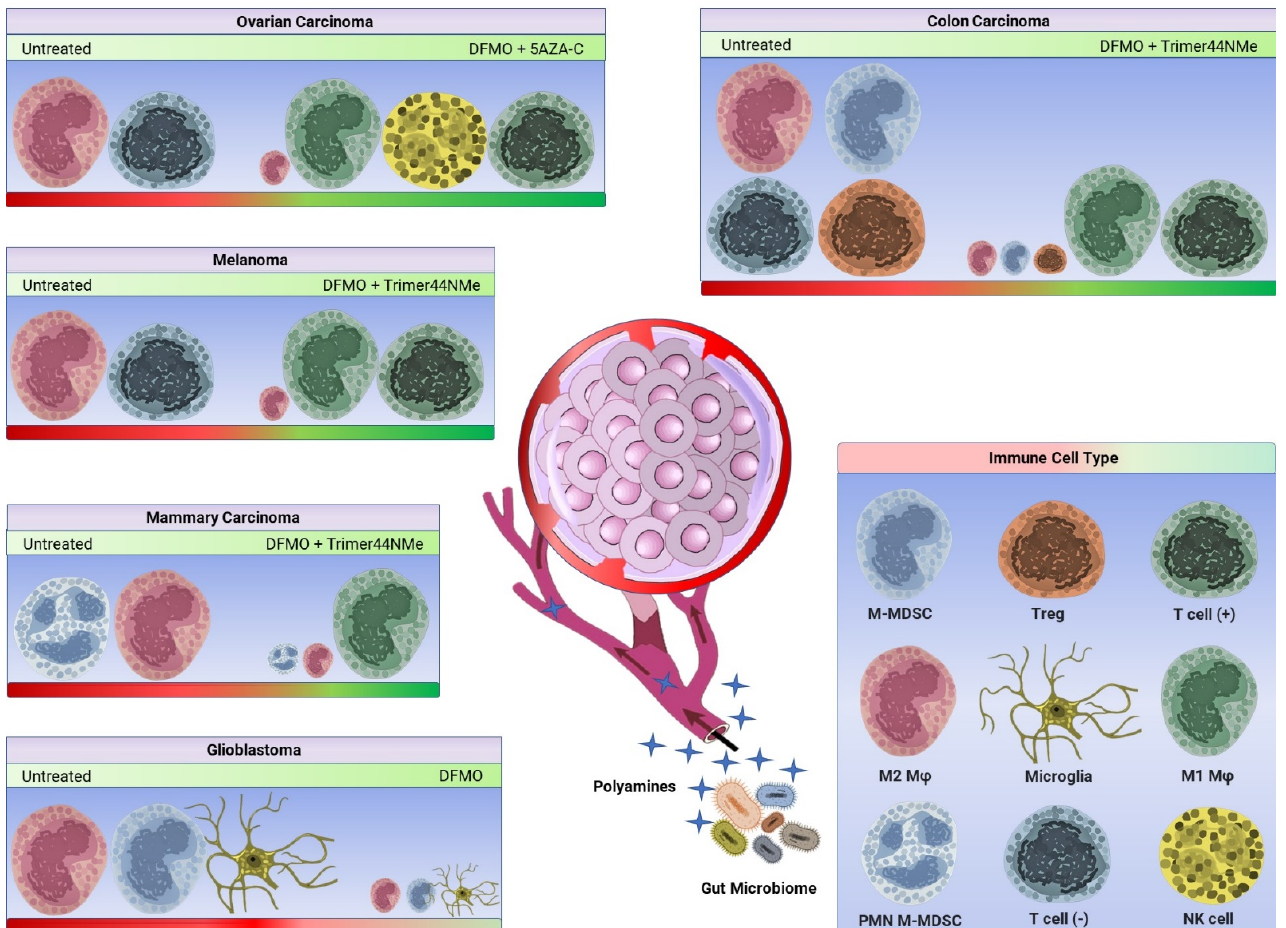
Figure 2. Polyamine blocking strategies decrease immunosuppression in multiple animal models of cancer. The tumor microenvironment (TME) presents anti-inflammatory cytokines and chemokines to support tumor growth; tumor- and gut microbiome-derived polyamines may further enhance immunosuppression [17,22]. Of the cancers examined, the respective panels are comprised of no-treatment (left) and treatment groups (right) and delineate significant alterations in the immune landscape. The red-green bar indicates the shift from an anti-inflammatory to pro-inflammatory phenotype, and the size of respective immune cells indicates the shift in observed frequencies as reported in the following articles. The immune cell types are labeled accordingly, and of note T cell ( − ) indicates a non-inflammatory and/or exhausted phenotype. DFMO and Trimer44NMe polyamine transport inhibitor (PTI) significantly reduced Ly6G+ polymorphonuclear myeloid-derived suppressor cells (PMN-MDSCs) and M2 macrophages (M2 M ϕ ) in the 4T1 orthotopic mammary carcinoma model [33]. DFMO and Trimer44NMe significantly increased IFN γ -expressing cells and T cells, and decreased M2 macrophages and/or monocytic MDSCs (M-MDSCs), as well as Tregs in the CT26.CL25 subcutaneous colon carcinoma model [30]. DFMO and Trimer44NMe significantly increased IFN γ -expressing myeloid cells and T cells in the B16F10-sTAC subcutaneous melanoma model [30,33]. DFMO treatment alone significantly decreased M2 M ϕ and/or M-MDSCs as well as microglia in the CT-2A orthotopic glioblastoma model [28]. DFMO and 5-azacytidine (5AZA-C) significantly reduced M2 macrophages and increased pro-inflammatory M1 macrophages (M1 M ϕ ), T and NK cells in the VDID8 intraperitoneal ovarian carcinoma model